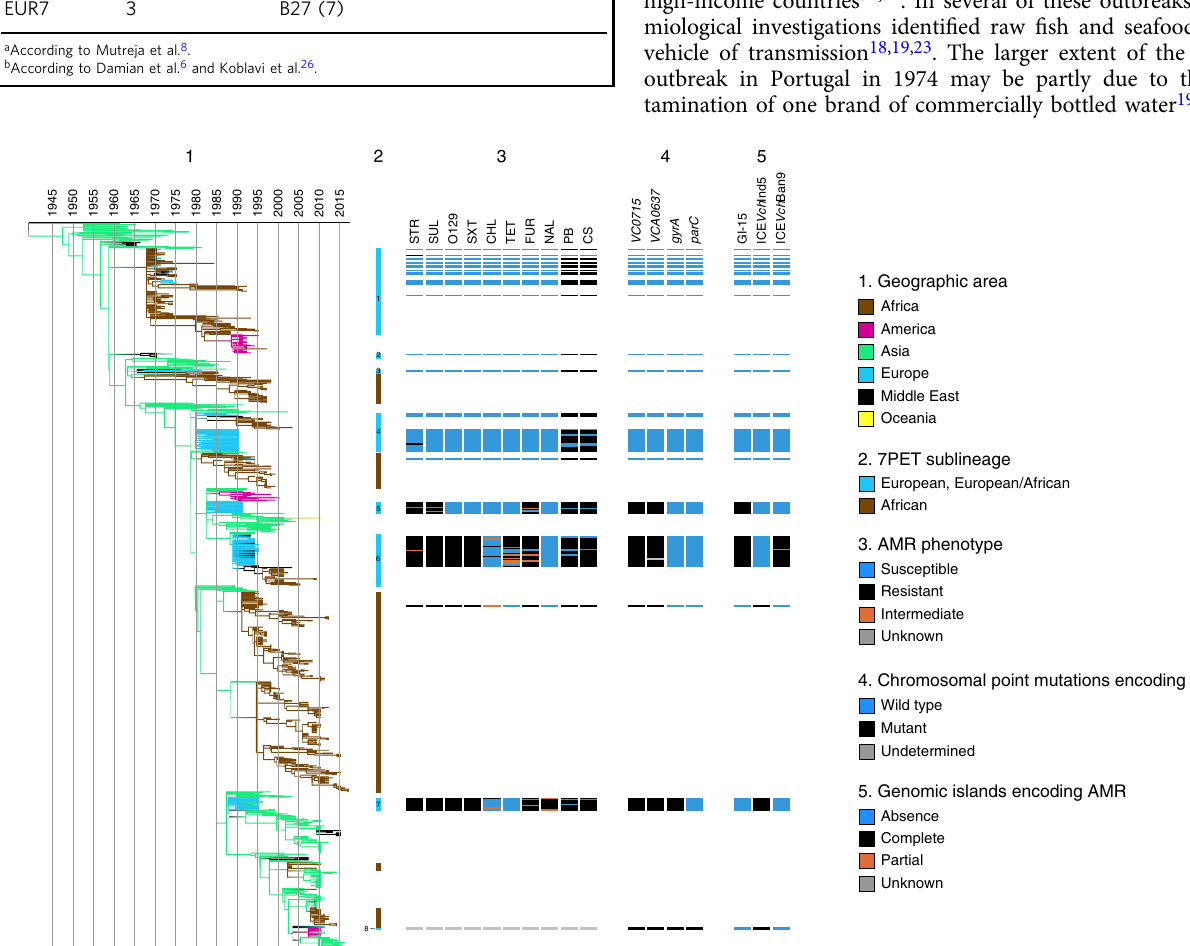
Fig. 3 Phenotypic and genetic characterization of antibiotic resistance in the European seventh pandemic V. cholerae O1 El Tor isolates analyzed here. (1) Timed phylogeny, identical to that in Fig. 1, but represented vertically. (2) The seventh pandemic V. cholerae O1 El Tor (7PET) sublineages are indicated. The names of the European and European/African sublineages are indicated by a one-digit number within or next to the blue line and corresponding to that found in the sublineage name (e.g., 1 for EUR1, 2 for EUR2/AFR3, etc). The antimicrobial resistance (AMR) phenotype for 10 antibiotics, the presence of chromosomal AMR genes (4), and genomic islands encoding AMR (5) are shown for each isolate, according to its position in the phylogeny. More detail about the genes and genomic islands encoding AMR is provided in the footnotes of Table 3. The abbreviations used for the antibiotics are as follows: STR streptomycin; SUL sulfonamides; O129 vibriostatic agent O/129; SXT trimethoprim-sulfamethoxazole; CHL chloramphenicol; TET tetracycline; FUR furazolidone; NAL nalidixic acid; PB polymyxin B; CS colistin. Note that 18 European isolates identi fi ed as outliers (Supplementary Data 1) are not represented in this timed phylogeny.